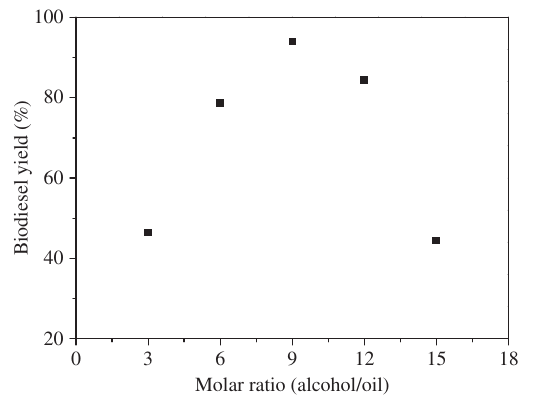
Figure 5 Effect of different organic solvents on biodiesel yield [reaction conditions: w (molar ratio of water to surfactant) 3.5, 0 lipase 4.4%, molar ratio (methanol/oil) 9, time 16 h, temperature 40 ° C, stirrer speed 250 rpm].